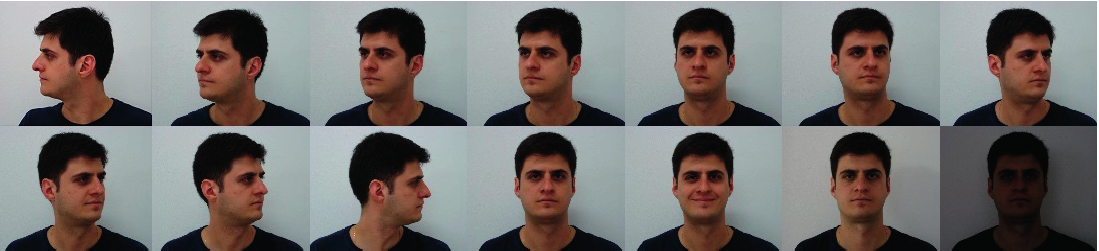
Figure 8. All 14 images of an individual in FEI Face Database.